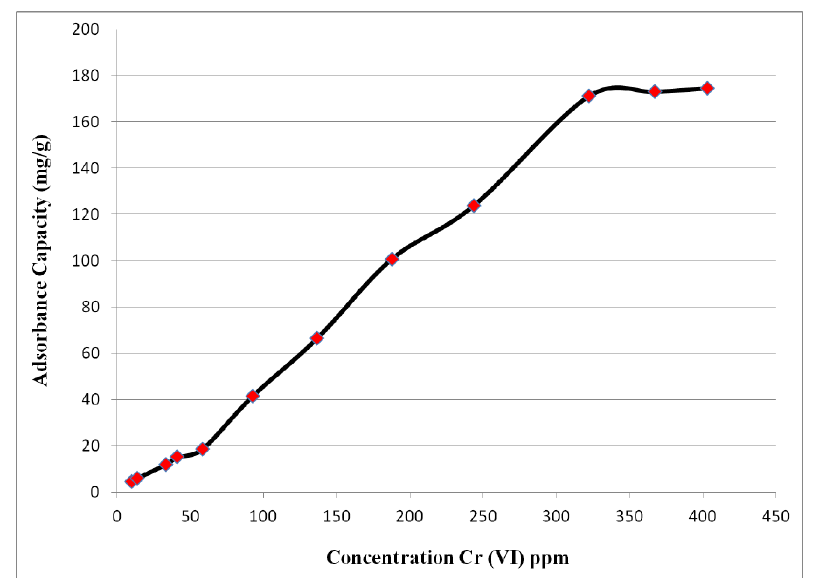
Figure 5. Isotherm for adsorption of Cr(VI) onto